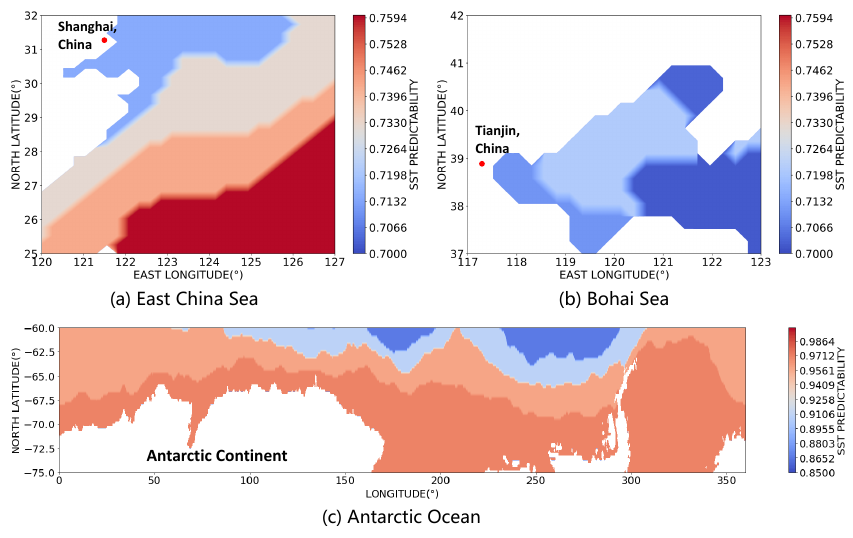
Figure 10. The predictability of clustered SST in the ( a ) East China Sea, ( b ) the Bohai Sea, and ( c ) the Antarctic Ocean within 20 years from 2002 to